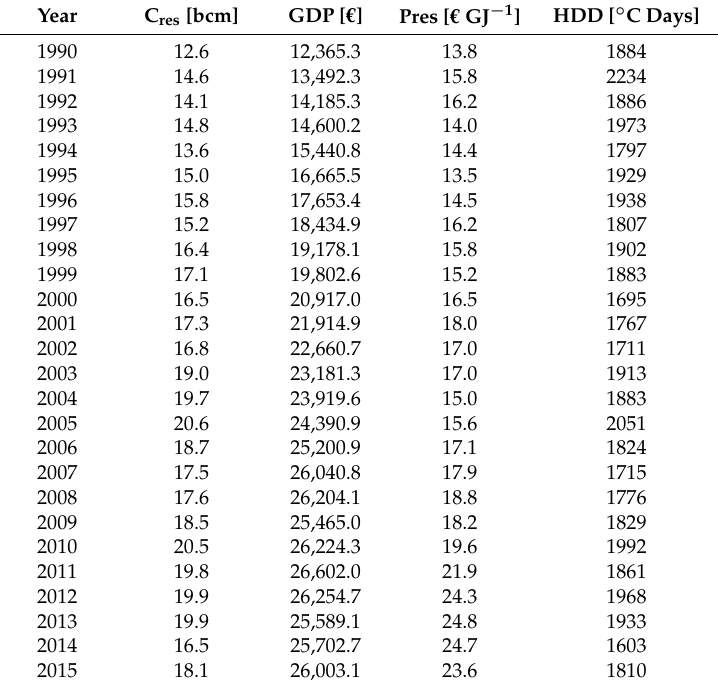
Table 1. Reference data (observed values) for C res , gross domestic product (GDP), P res and heating degree days (HDD).